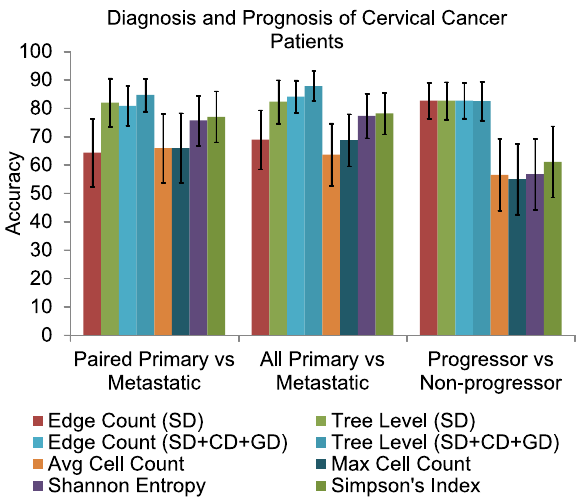
Figure 8. Classification results on the CC dataset. Prediction accuracy on three different classification tasks of CC samples of an SVM classifier using tree-based and cell-based features. Each of the two tree- based features, edge count and tree level cell percentage, is derived from phylogenetic trees built using two different models of tumor progression, namely SD and combination of SD, CD and GD. Two cell- based features, average gain/loss and maximum copy number of each gene, and two information theoretic measures of cell heterogeneity, Shannon entropy and Simpson’s index, are used.